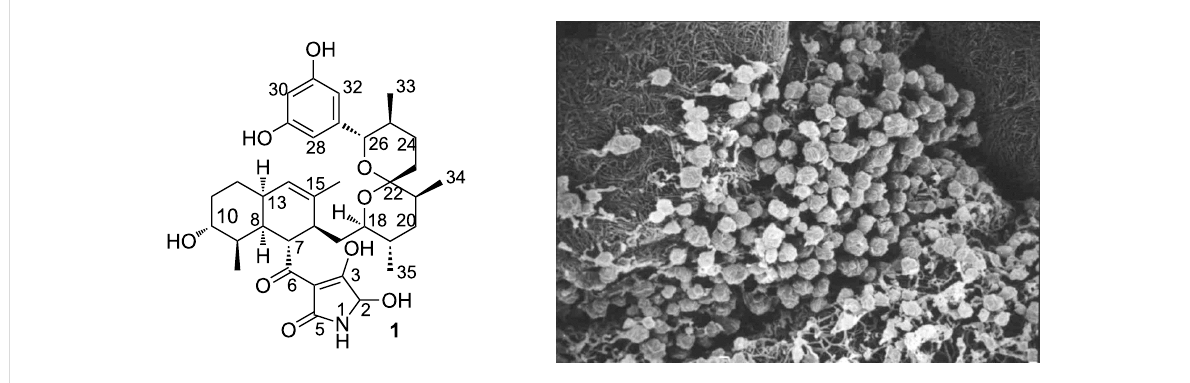
Figure 1: Structure of integramycin ( 1 ) and its producing organism, Actinoplanes sp. ( Photo: J. Wink, HZI, Microbial drugs ).